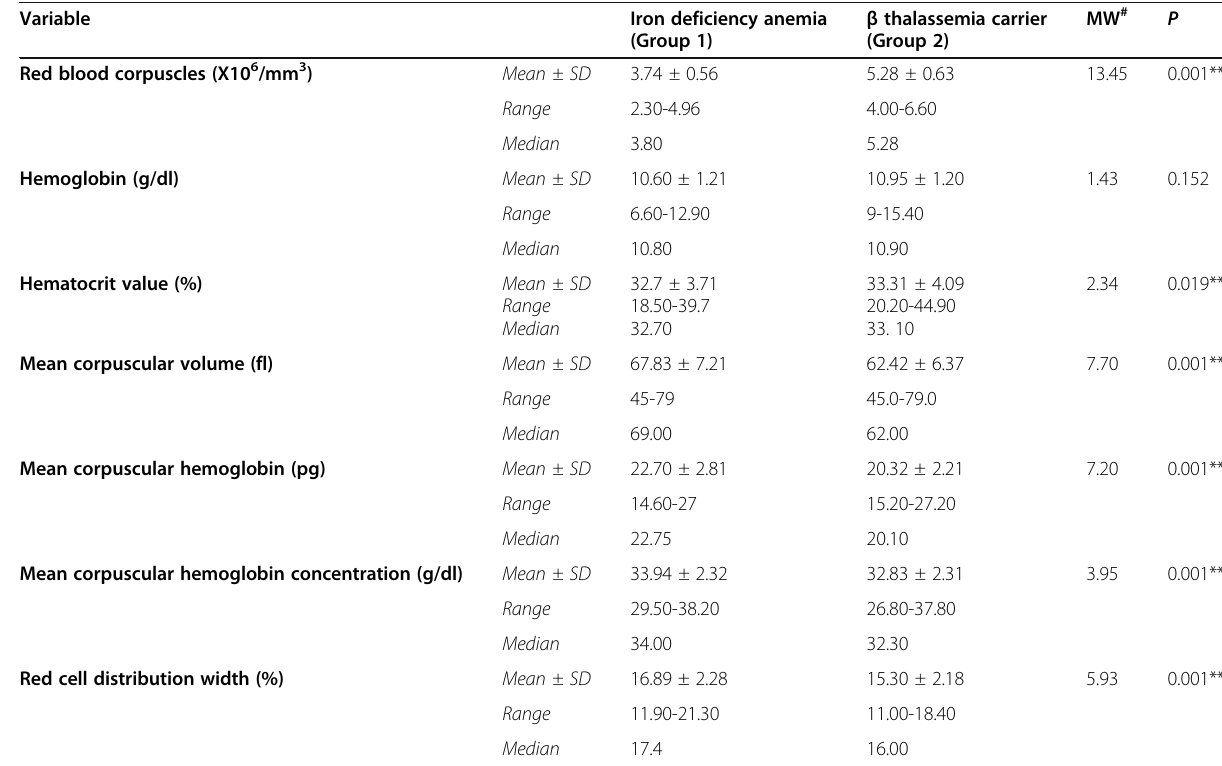
Table 2 Complete blood count of β thalassemia carriers and iron deficiency anemia participants in Mid Nile Delta